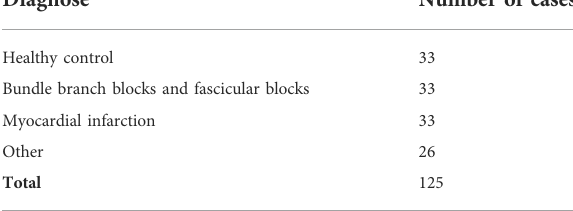
TABLE 2 Preview of CSE validation database